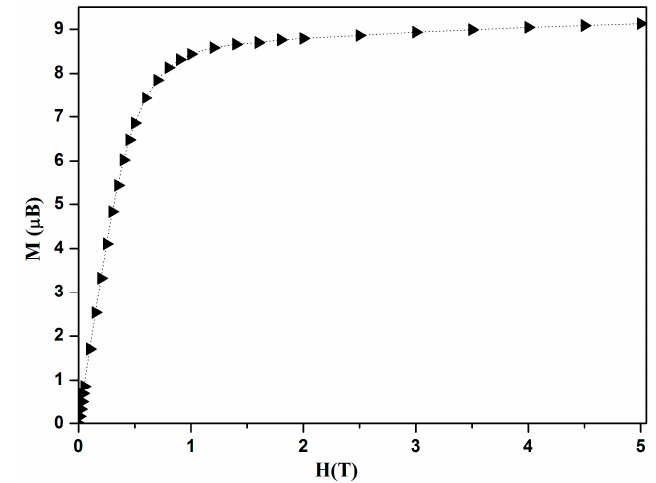
Figure 3. Field dependence of the magnetization at 2 K fora single crystal of [Ni 4 ] with the magnetic field set parallel to the magnetic easy axis.